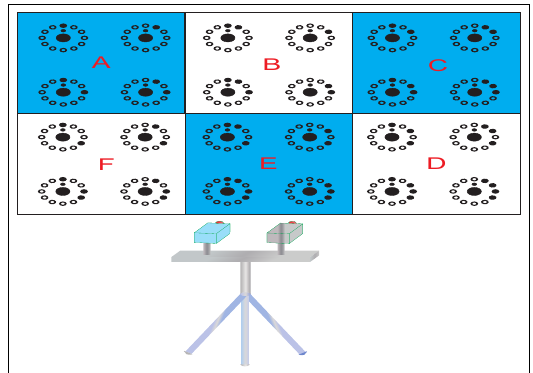
Figure 7. The schematic diagram of a flexible solar panel system.